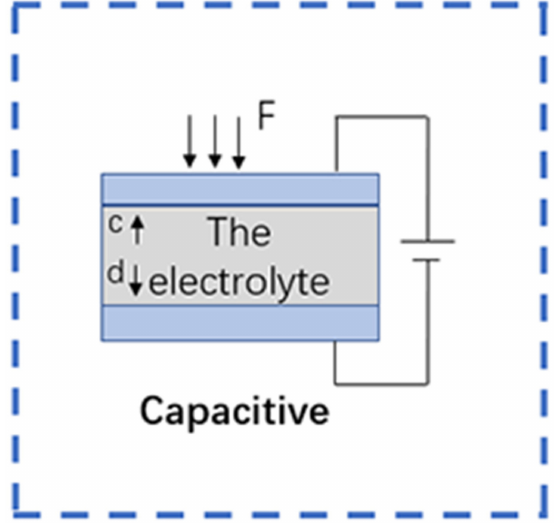
Figure 7. Diagram of the capacitive flexible sensor signal conversion